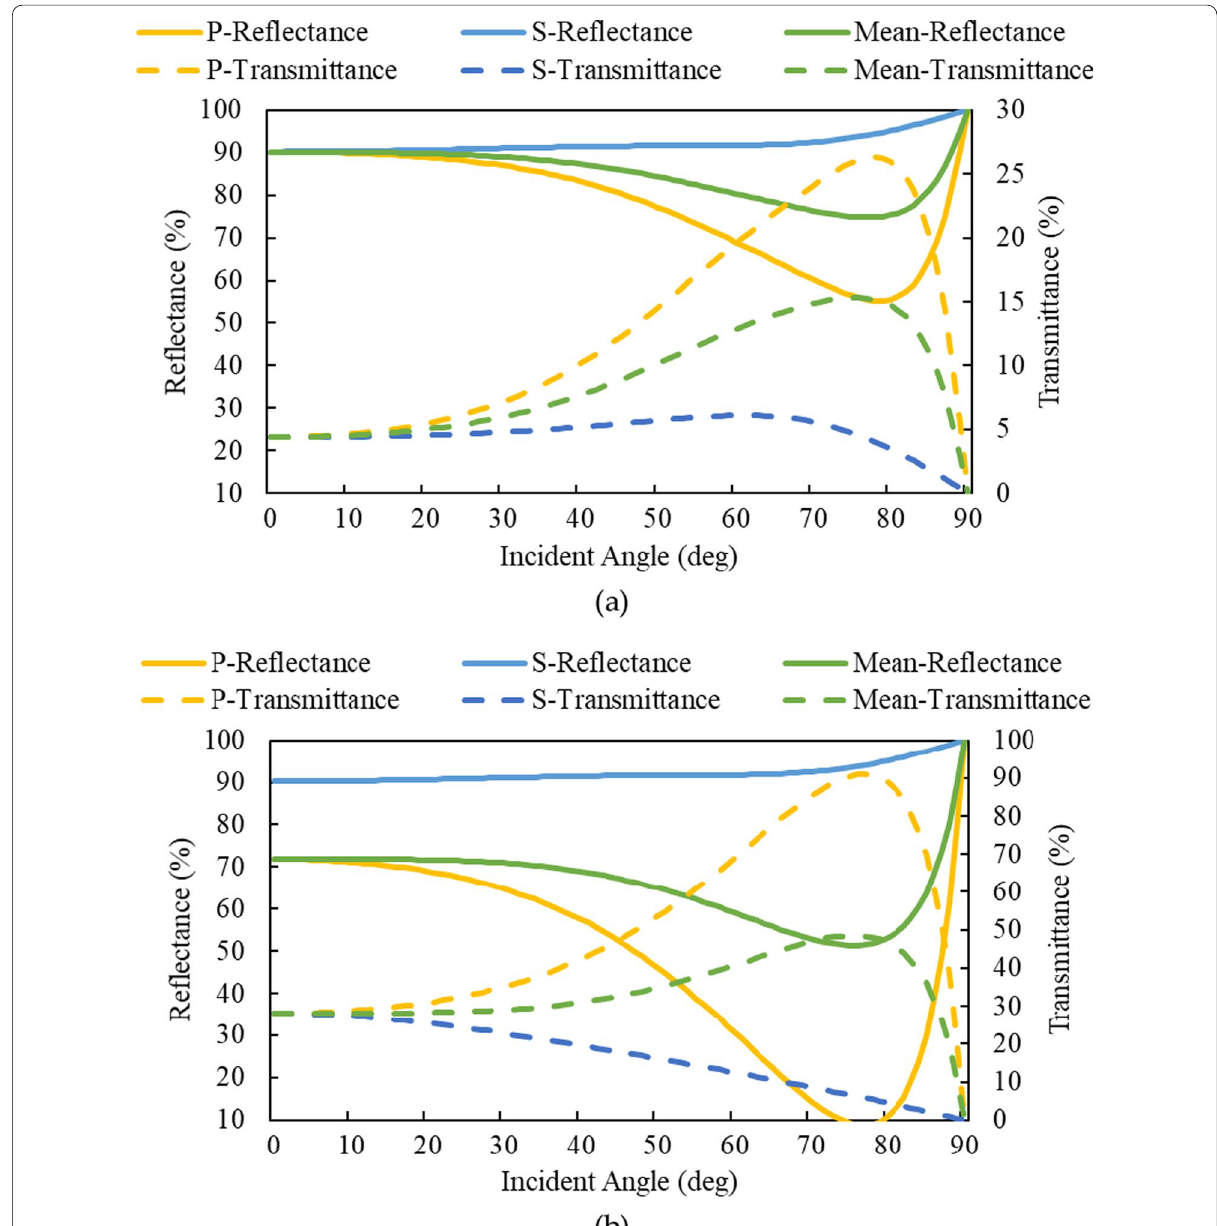
Fig. 5 Reflectance and transmittance ratio changes of the simulated a Al/(HL) 2 for incident angles of 0–90°and b (HL) 2 for incident angles of